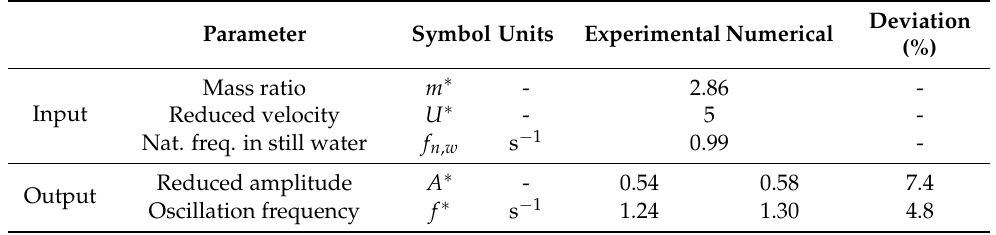
Table 3. Comparison of Experimental and Numerical Simulation Results.